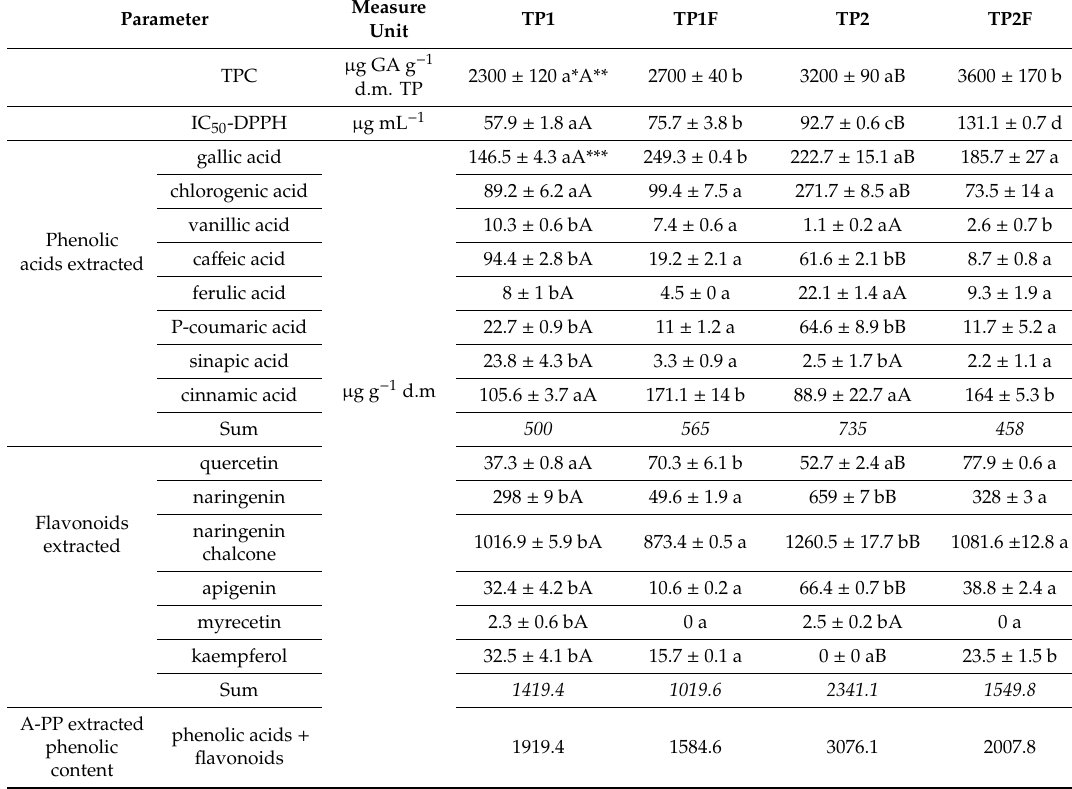
Table 3. Total phenolic content (TPC), aglycone-polyphenols (A-PP) polyphenols extracted content, and antioxidant activity of TP and